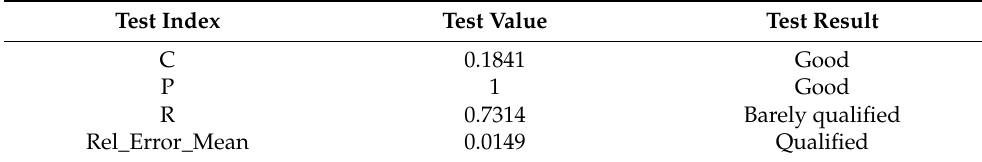
Table 7. Accuracy of the model